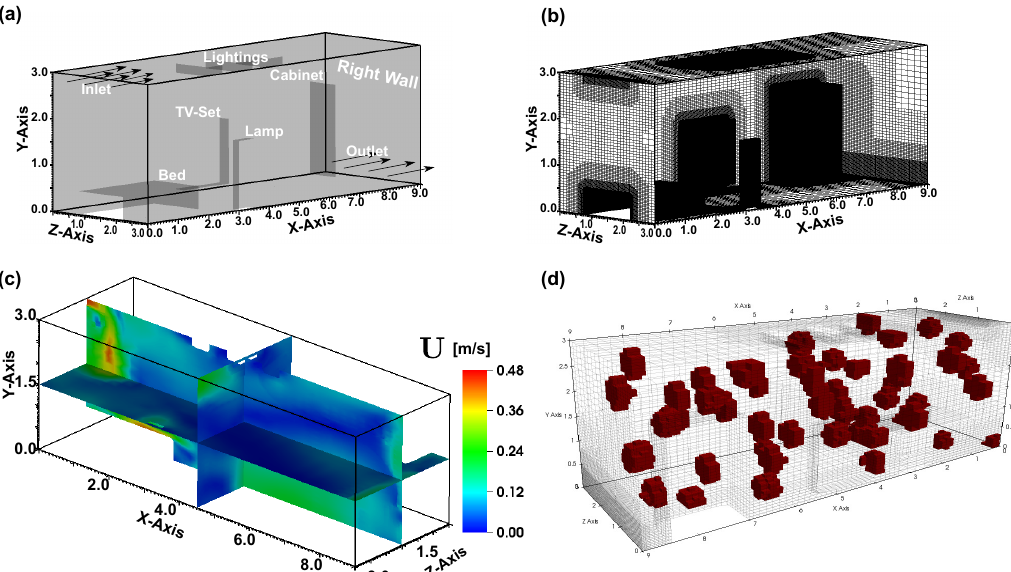
Figure 7. ( a ) The geometry used in the 3D room is used for the construction of the Markov matrix. ( b ) The computational mesh is used for performing the CFD for computing the flow field in the room. ( c ) The computed velocity is shown on the midplane of the room. ( d ) The sampled release locations which are going to be used for computing the likelihood in the Bayesian